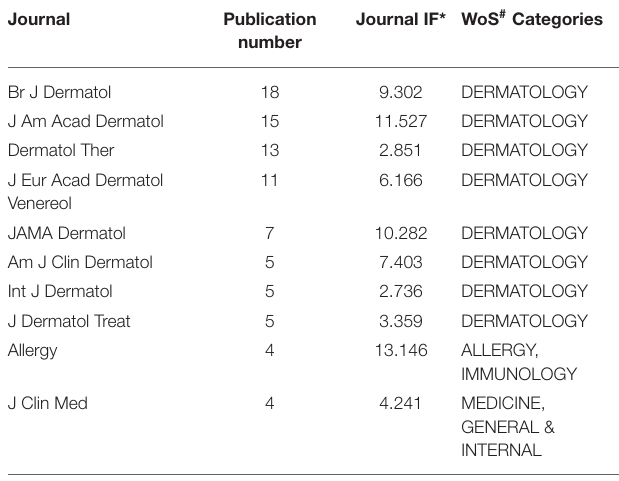
TABLE 1 | The top 10 journals with the largest number of published articles in the study